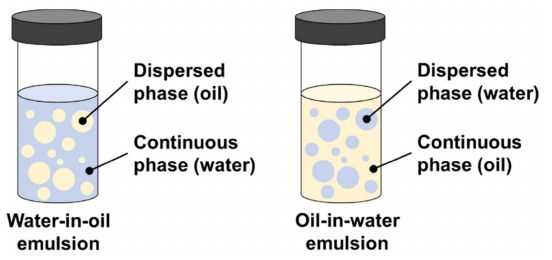
Figure 20. Classical types of emulsion.